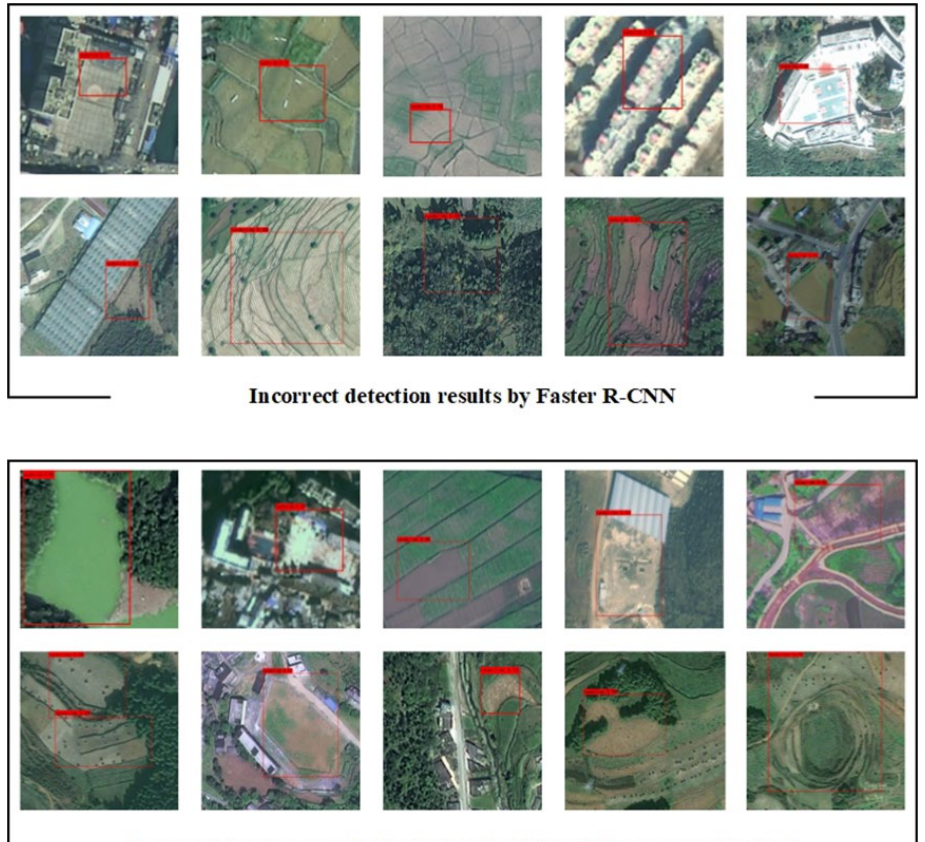
Figure 4. Illustration on incorrect detection results.